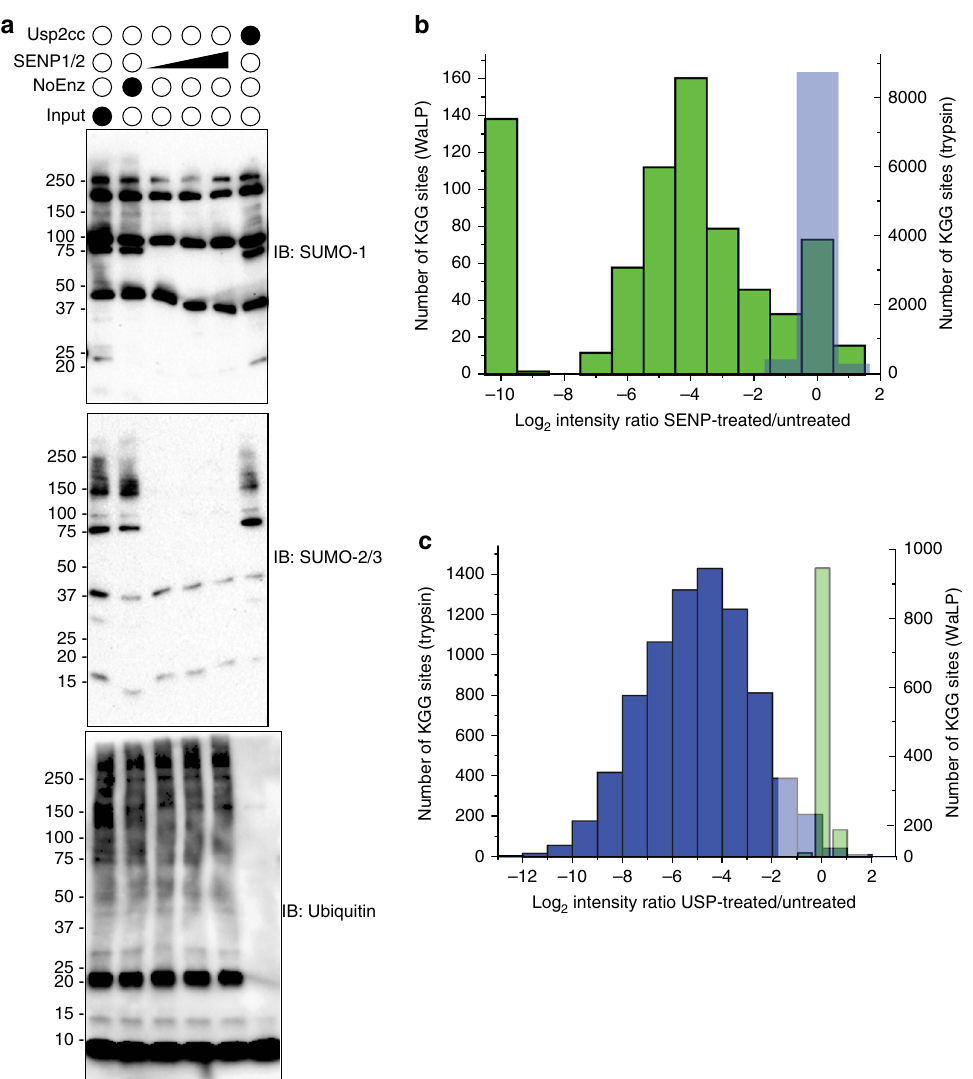
Fig. 3 Identi fi cation and quantitation of SUMO and Ub modi fi cation sites upon in vitro deSUMOylation in Hela cell extracts. a Extracts were either untreated or treated with varying amounts of SENP1 and SENP2 enzymes or Usp2cc and then analyzed by SDS-PAGE and blotted for SUMO1 or SUMO2/3 or ubiquitin. b Bar graph showing results from quantitation of KGG-peptides after treatment with SENP1/2, illustrating the reduction of KGG sites observed after WaLP digestion. Green bars indicate SUMO modi fi cation sites identi fi ed and quanti fi ed upon WaLP digestion (left, y axis) and blue bars indicate Ub modi fi cation sites identi fi ed and quanti fi ed upon trypsin digestion (right, y axis). c Bar graph showing results from quantitation of KGG-peptides after treatment with Usp2cc, illustrating the retention of KGG sites observed after WaLP digestion. Colors are the same as in